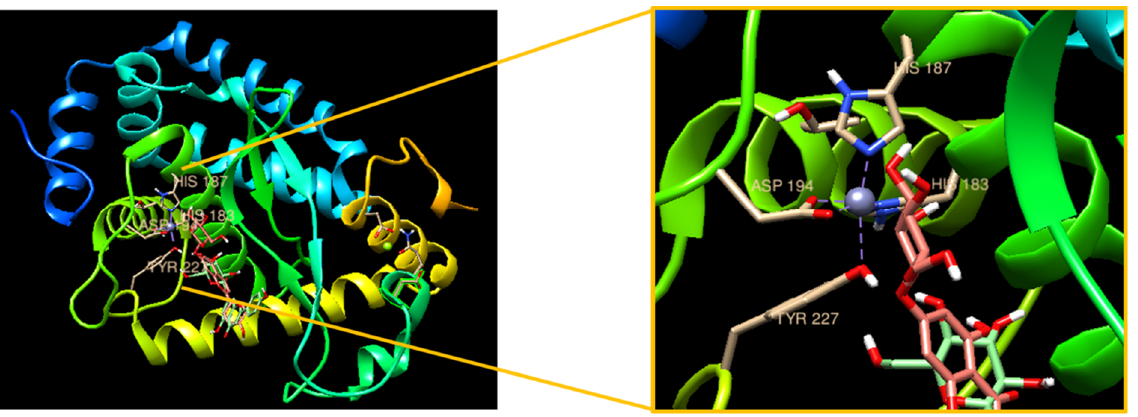
Figure 6. In silico molecular docking analysis of the ligand apigetrin with target NF-κB. The 3D structure of NF-κB bound efficiently with the compound apigetrin with its interacting amino acids TYR, ASP, and HIS.